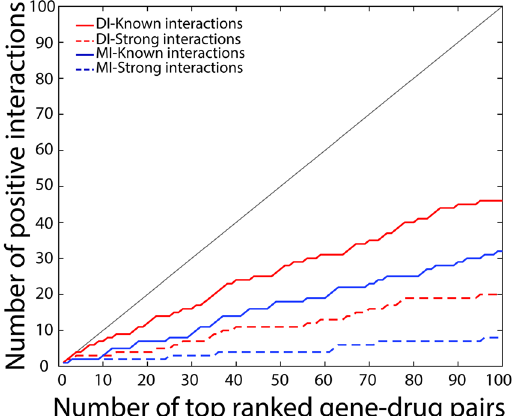
Figure 6. Prediction of gene expression and drug response pairs using DI and MI. Solid line plots indicate gene expression-drug response pairs with known interactions (y-axis) against total number of gene-drug pairs (x-axis) ranked by DI values (red) or MI (blue) values. Dash line plots indicate coupling pairs identified as strong interactions . DI yields better performance results at predicting gene-drug relationships compared to